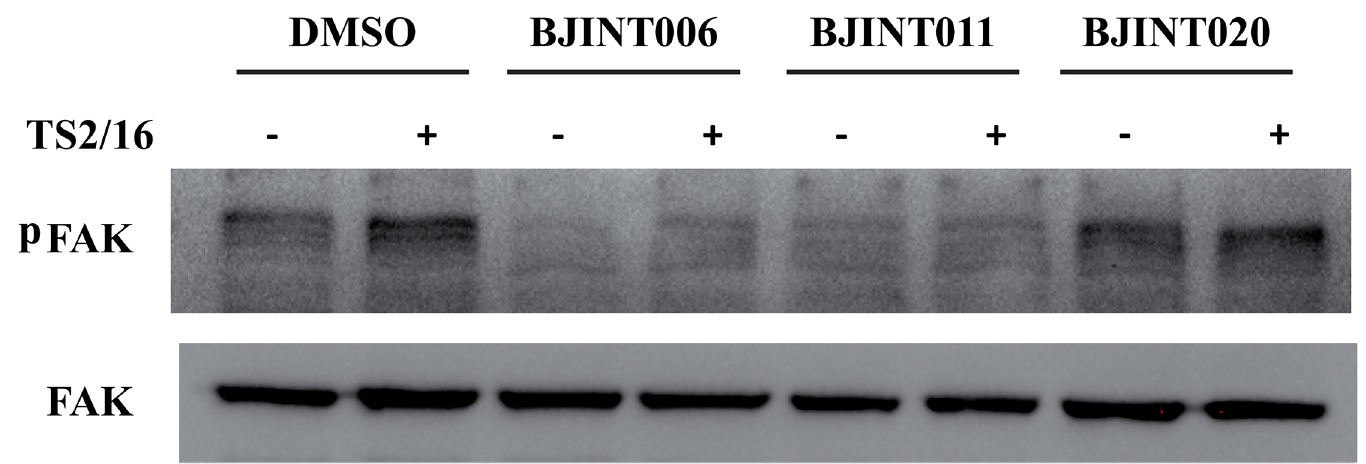
Fig 6. BJINT derivatives blunt integrin outside-in signaling. Auto-phosphorylation of FAK, one of the earliest integrin dependent signaling events was used as readout of integrin signaling activity. 10 7 HeLa cells were harvested and incubated for 1 h at 37°C in D-MEM, then suspended at the concentration of 10 6 cells/mL as described in [35] with TS2/16 monoclonal antibody and BJINT molecules or DMSO. Cells were centrifuged and lysed in Laemmli's sample buffer and analyzed by Western